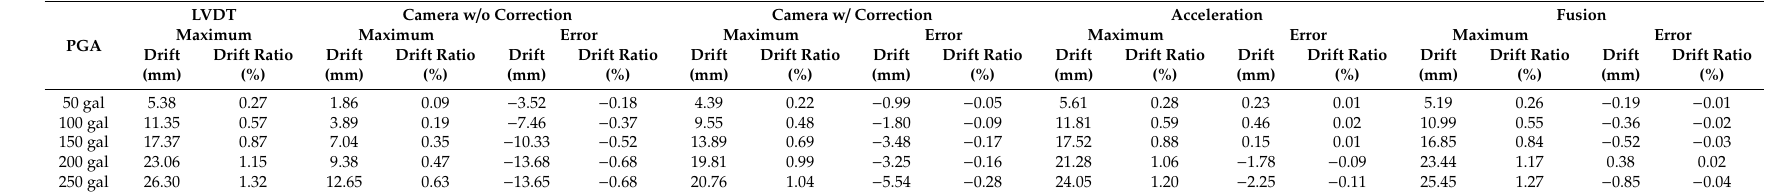
Table 1. Maximum interstory drift values and drift ratios during the five earthquake